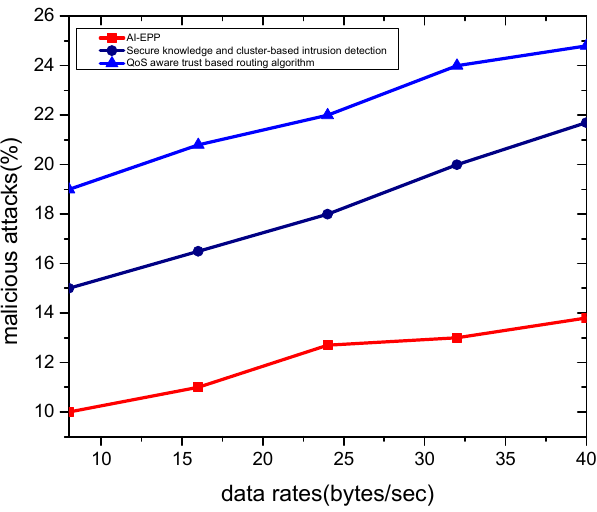
Figure 10. Malicious attacks comparison using simulations with varying data rates.